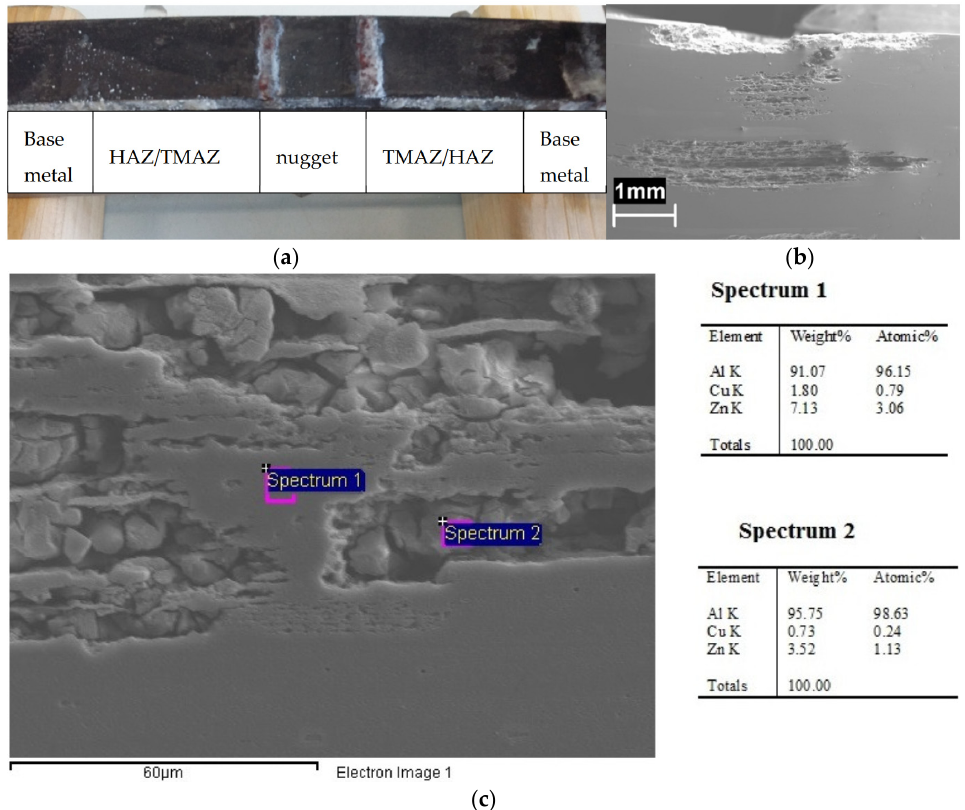
Figure 9. ( a ) Image of a 4PBB specimens after the test: an intense localized attack in the correspondence of the TMAZ and ( b ) SEM image of the metallographic longitudinal section of the loaded specimen in which is visible the deviation of the attack along the rolling direction, ( c ) particular of the attack and EDX analysis.